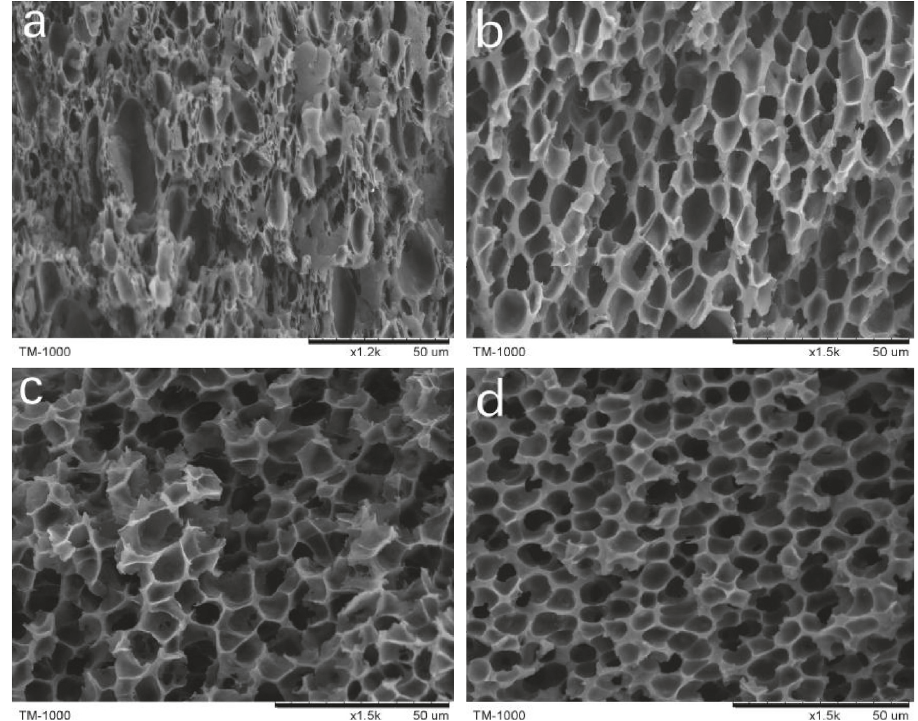
Figure 8: Cell structure of foaming material under different foaming pressure (2h, 110 ° C): (a) foaming pressure 12MPa, (b) foaming pressure 14MPa, (c) foaming pressure 16MPa, and (d) foaming pressure 18MPa.